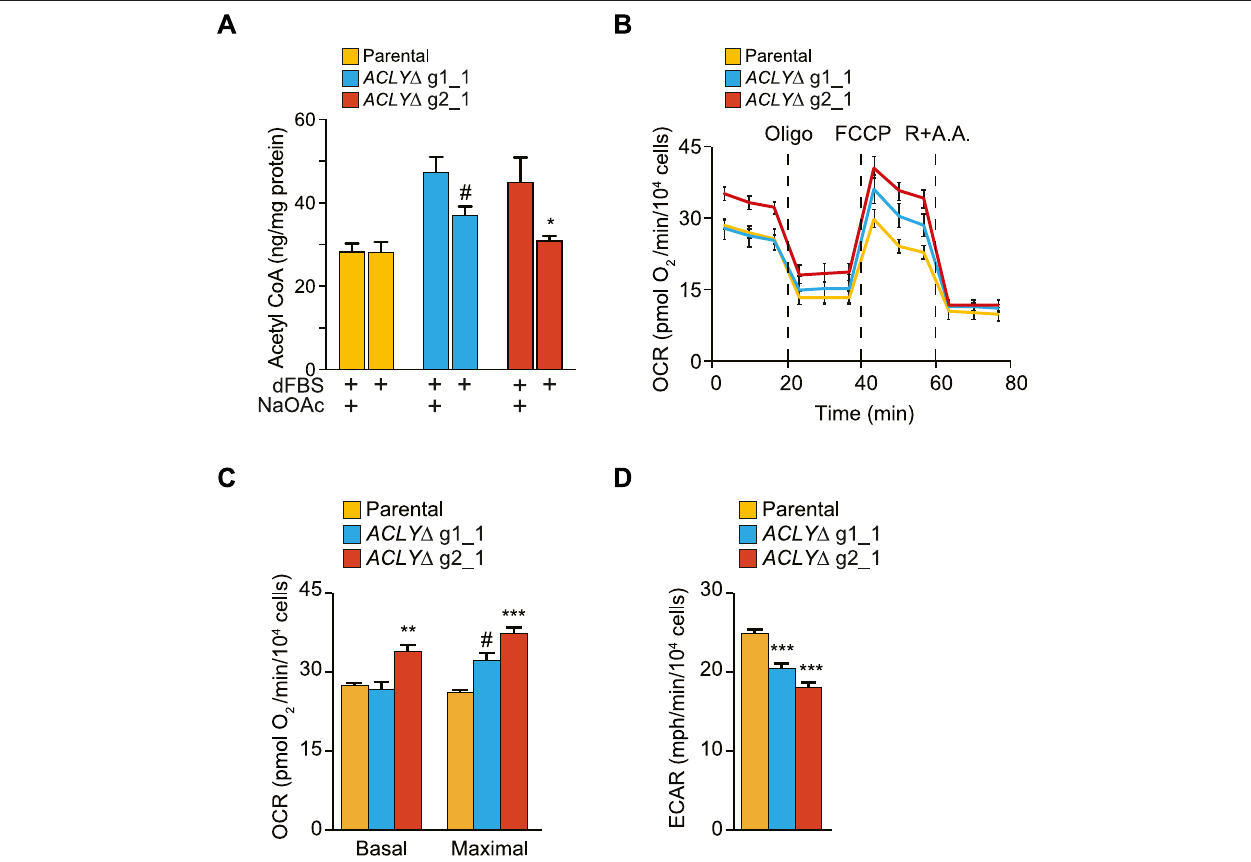
FIGURE 4 | HEK293 ACLY Δ cells have altered metabolism. (A) Quanti fi cation of acetyl-CoA in HEK293 ACLY Δ and parental cells incubated with and without NaOAc in medium containing 10% dFBS for 1 h using a fl uorometric assay. (B) OCRs were measured and normalized to cell numbers. Following basal respiration measurements, drugs that selectively target speci fi c components of the electron transport chain were sequentially injected. Oligomycin inhibits ATP synthase, blocking oxygen consumption coupled to ATP production. FCCP disrupts the proton gradient, thereby inducing maximal respiration. Finally, antimycin A (a complex III inhibitor) and rotenone (a complex I inhibitor) were simultaneously injected to completely block mitochondrial respiration, leaving only non-mitochondrial respiration. (C) Measurements of basal and maximal respiration in parental and ACLY Δ cells. (D) Basal ECARs in parental and ACLY Δ cells. For (B – D) , results from one representative experiment are shown, with 12 replicates/condition, out of at least three independent experiments. *** p < 0.001; ** p < 0.01; * p < 0.05; # p < 0.12.